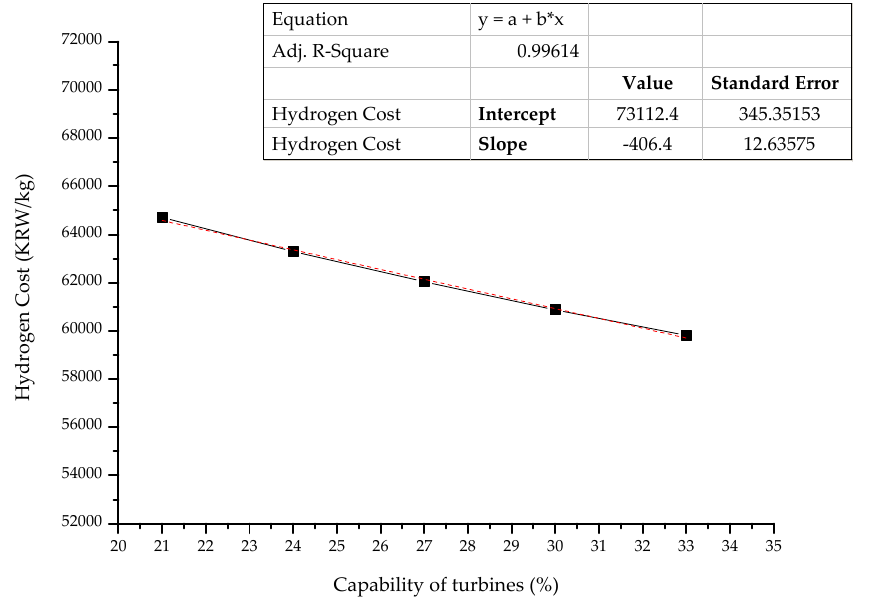
Figure 4. Correlation between the capability of wind turbines in the “H” Wind Farm and hydrogen cost *. * x -axis: capability of turbines (%), y -axis: hydrogen cost (KRW/kg). Solid line: y -values connecting line, Dot line: Regression line.